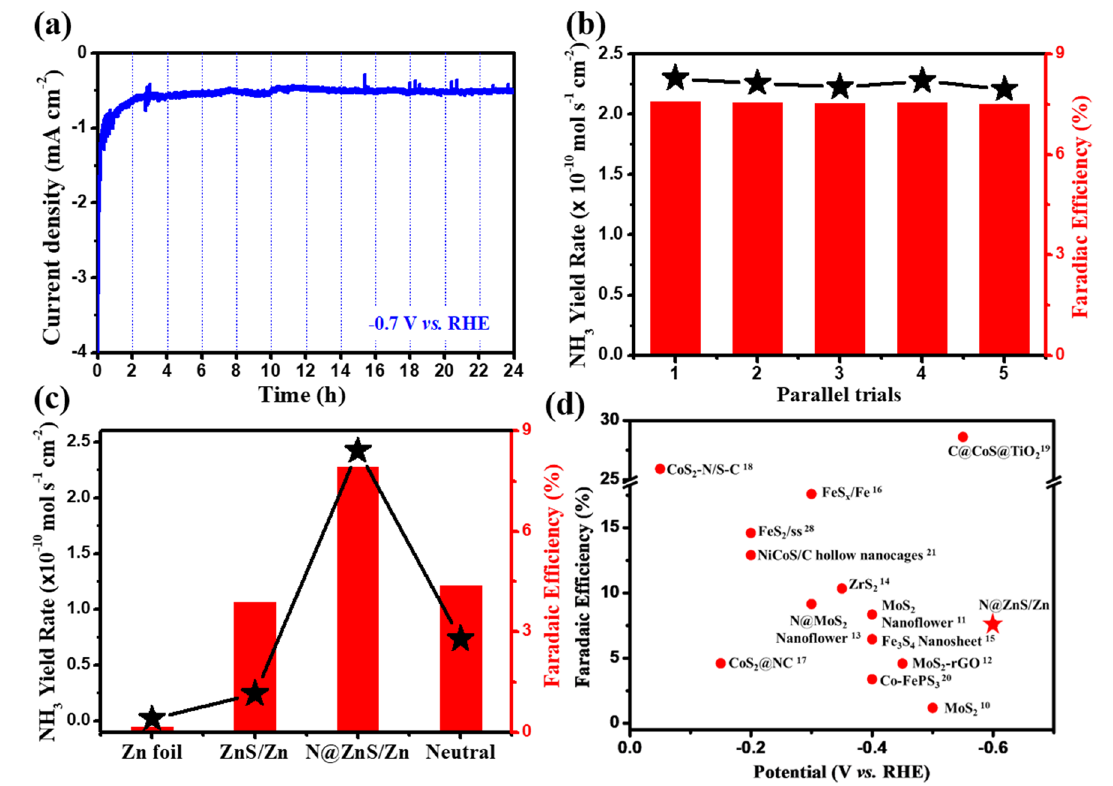
Fig. 5 a Time-dependent current density curve for N@ZnS/Zn at − 0.7 V vs RHE for 24 h. b 5 times repeating ENRR at − 0.6 V vs RHE; c Comparison FE and yield rate values of Zn foil, ZnS/Zn,